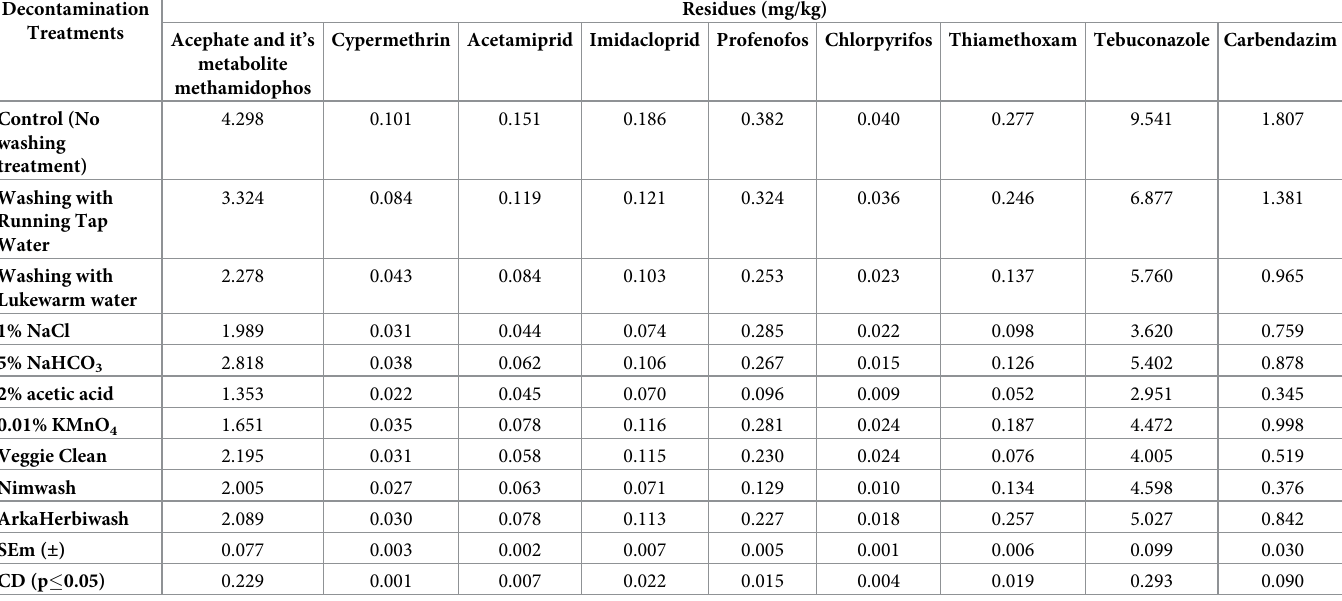
Table 4. Residues of pesticides in okra after different decontamination